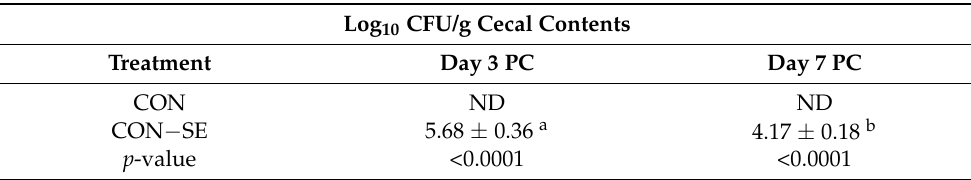
Table 1. Effect of Salmonella challenge on the concentration of Salmonella enteritidis in ceca of broiler